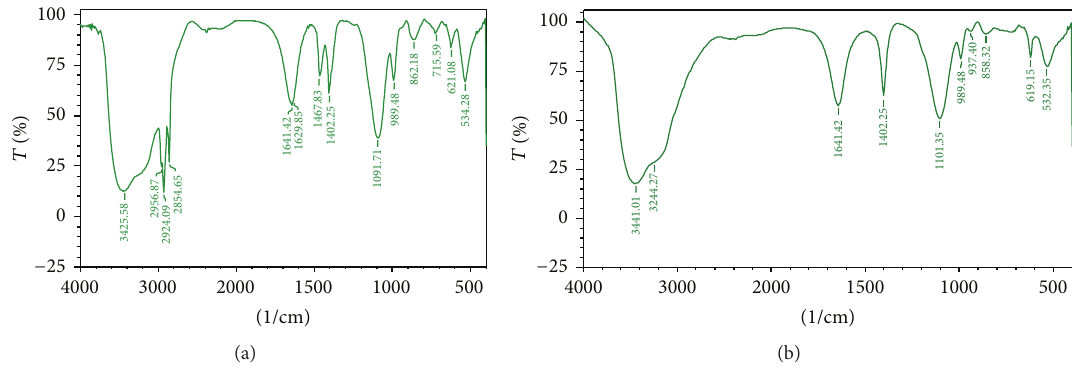
Figure 4: FTIR spectrum of diesel obtained before and after degradation. 1% diesel was used and incubated with the VITRSB1 strain. (a) Diesel before degradation with VITRSB1 strain. (b) Diesel after degradation with VITRSB1 strain.